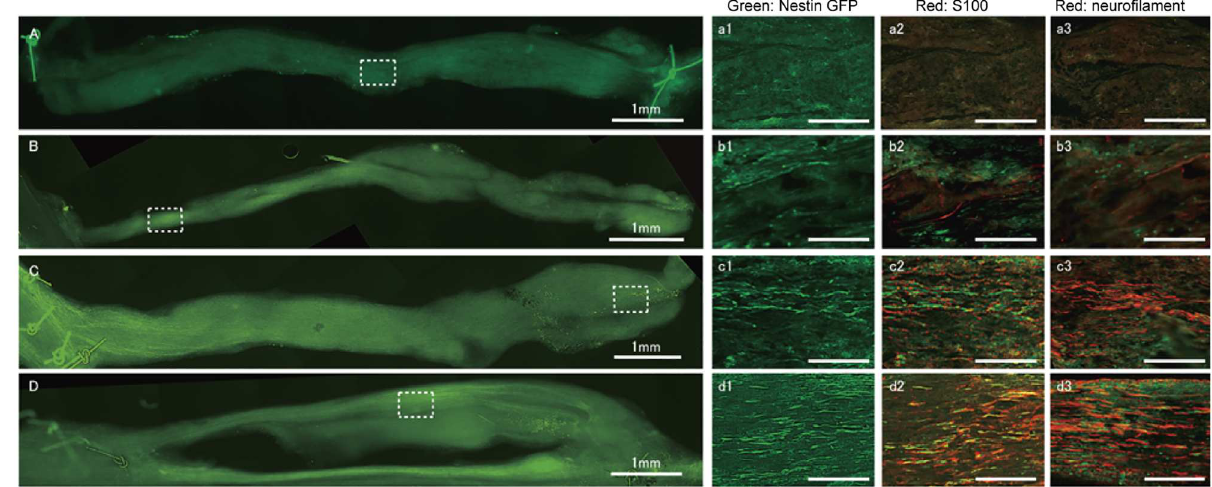
Fig 4. Confocal imaging and immunohistochemical staining of Schwann cell (SC) migration. A–D) Confocal image of acellularnerve allografts (ANGs) via four types of end-to-side(ETS) neurorrhaphies. Scale bar, 1 mm. a–d) Magnification of the inset outlined in A–D). a1– d1) Constitutive GFP expressionof nestin-GFP mice. a2–d2)Anti-S100antibody marked with Alexa 594-conjugated secondaryantibody (Red: S100, Green: nestin-GFP), a3–d3)Anti-neurofilament antibody marked with Alexa 594 conjugatedsecondary antibody (Red: neurofilament,Green: nestin-GFP). A) In the control group, no migratedSCs and regenerated axons were observed. B) In the intact ETS group, a few SCs could migrate to nearbyETS coaptation; however,no regenerated axons were observed. C) In the unilateralETS group, a small numberof SCs migrated to the distal edge of the ANG, and a few regenerated axons were also confirmedat the distal edge of the graft. D) In the bilateralETS group, a large number of migratedSCs and abundantregenerated axons were confirmedthroughout the ANG. Scale bar, 100 μ